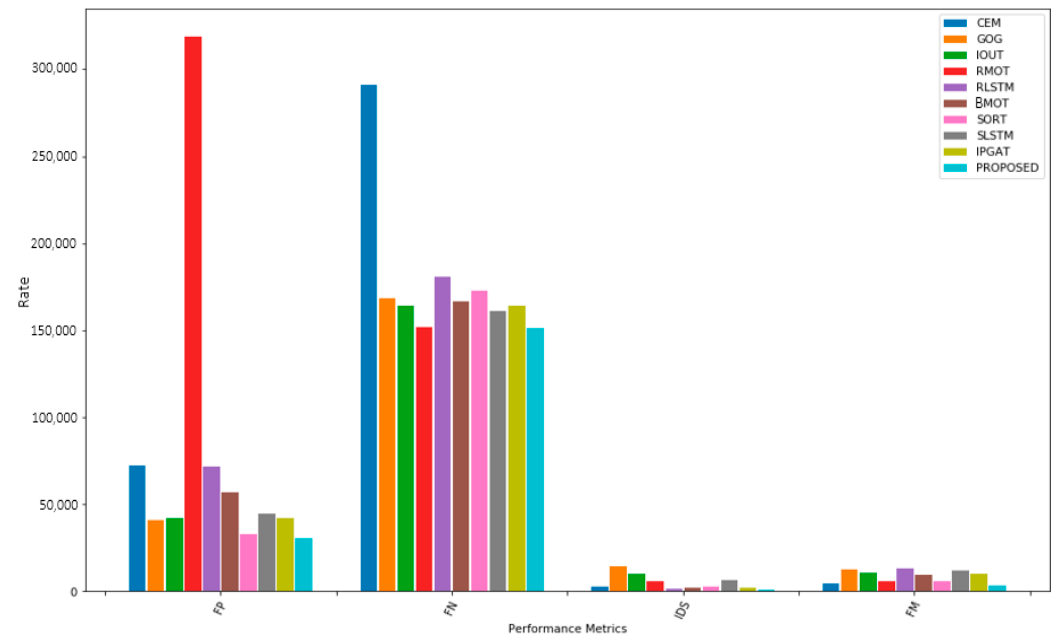
Figure 5. Comparative analysis of proposed method with existing methods based on the minimum false rate. CEM: continuous energy minimization, GOG: global optimal greedy, IOUT: intersection-over-union tracker, RMOT: relative motion online tracking, RLSTM: relative long short term memory, Bayesian multi-object tracking (BMOT), SORT: simple online and real-time tracking, SLSTM: social long short term memory.